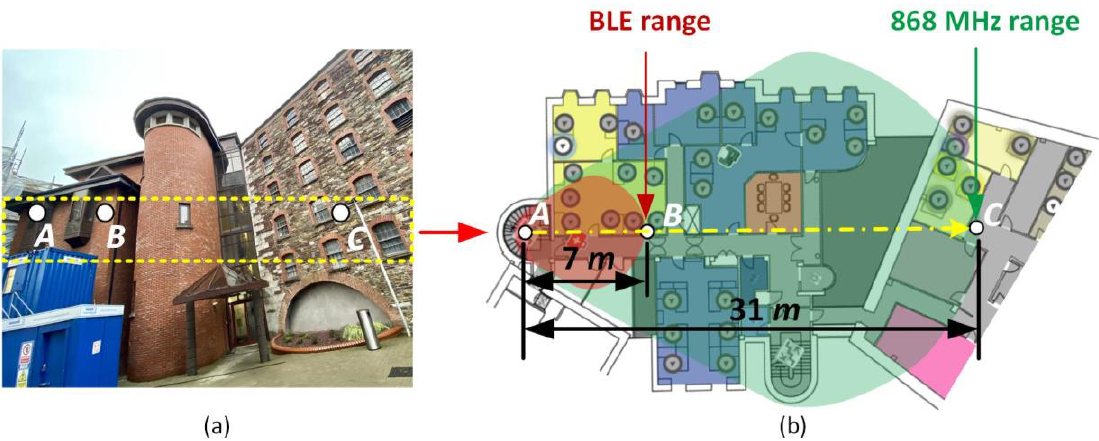
Figure 17. Indoor wireless communication range measurement ( a ) front view of the building, ( b ) 2D map of the floor where measurements were performed.